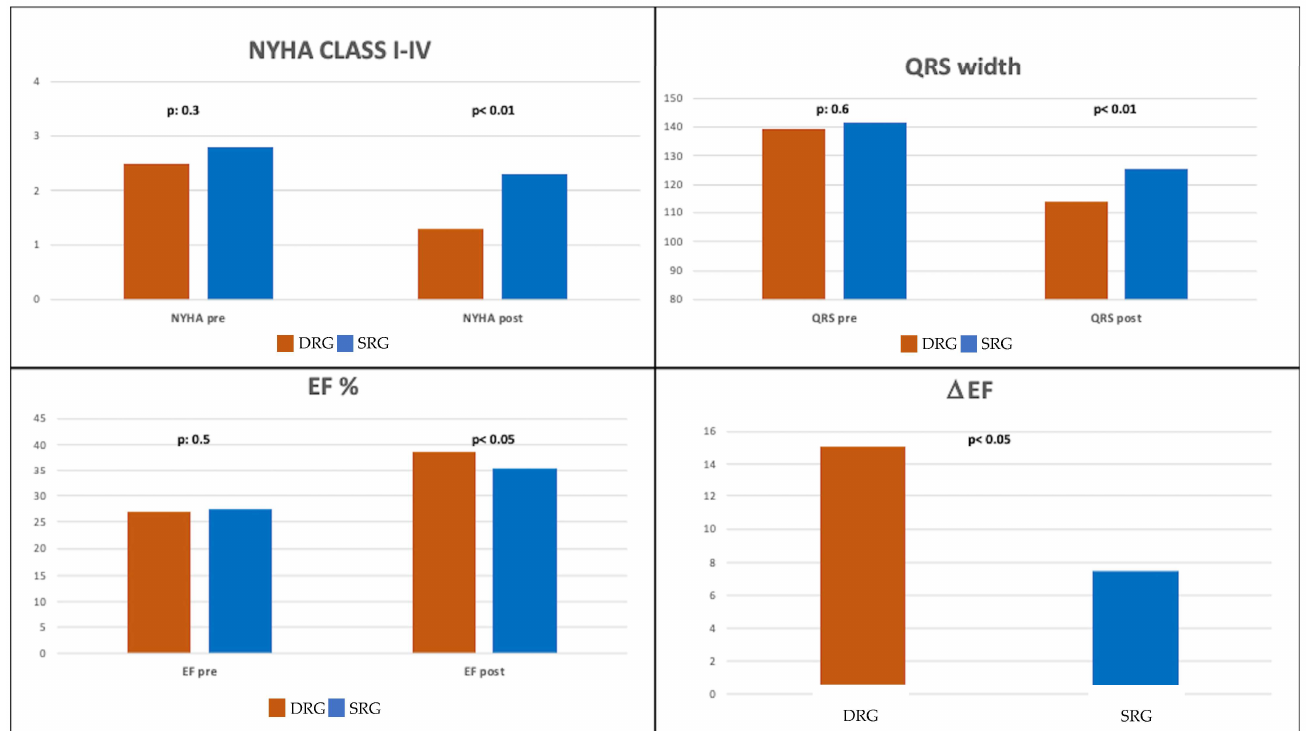
Figure 2. NYHA class, QRS width, EF, and increase of the EF before and after CRT/CSP therapy divided by DRG and SRG. DRG: resynchronization delayed guide group; SRG: resynchronization standard guide group. CSP: conduction system pacing; BiVP: biventricular pacing. Table 2. Procedural results after CRT stratified for DRG and